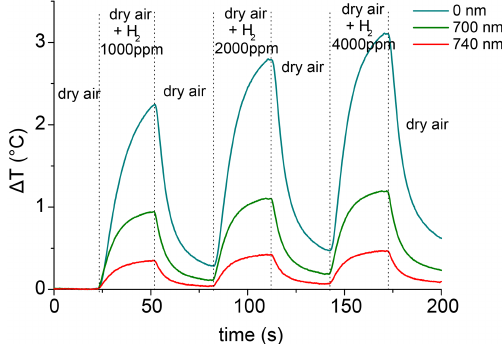
Figure 8. Thermal response of catalyst A coated by different thick- nesses of